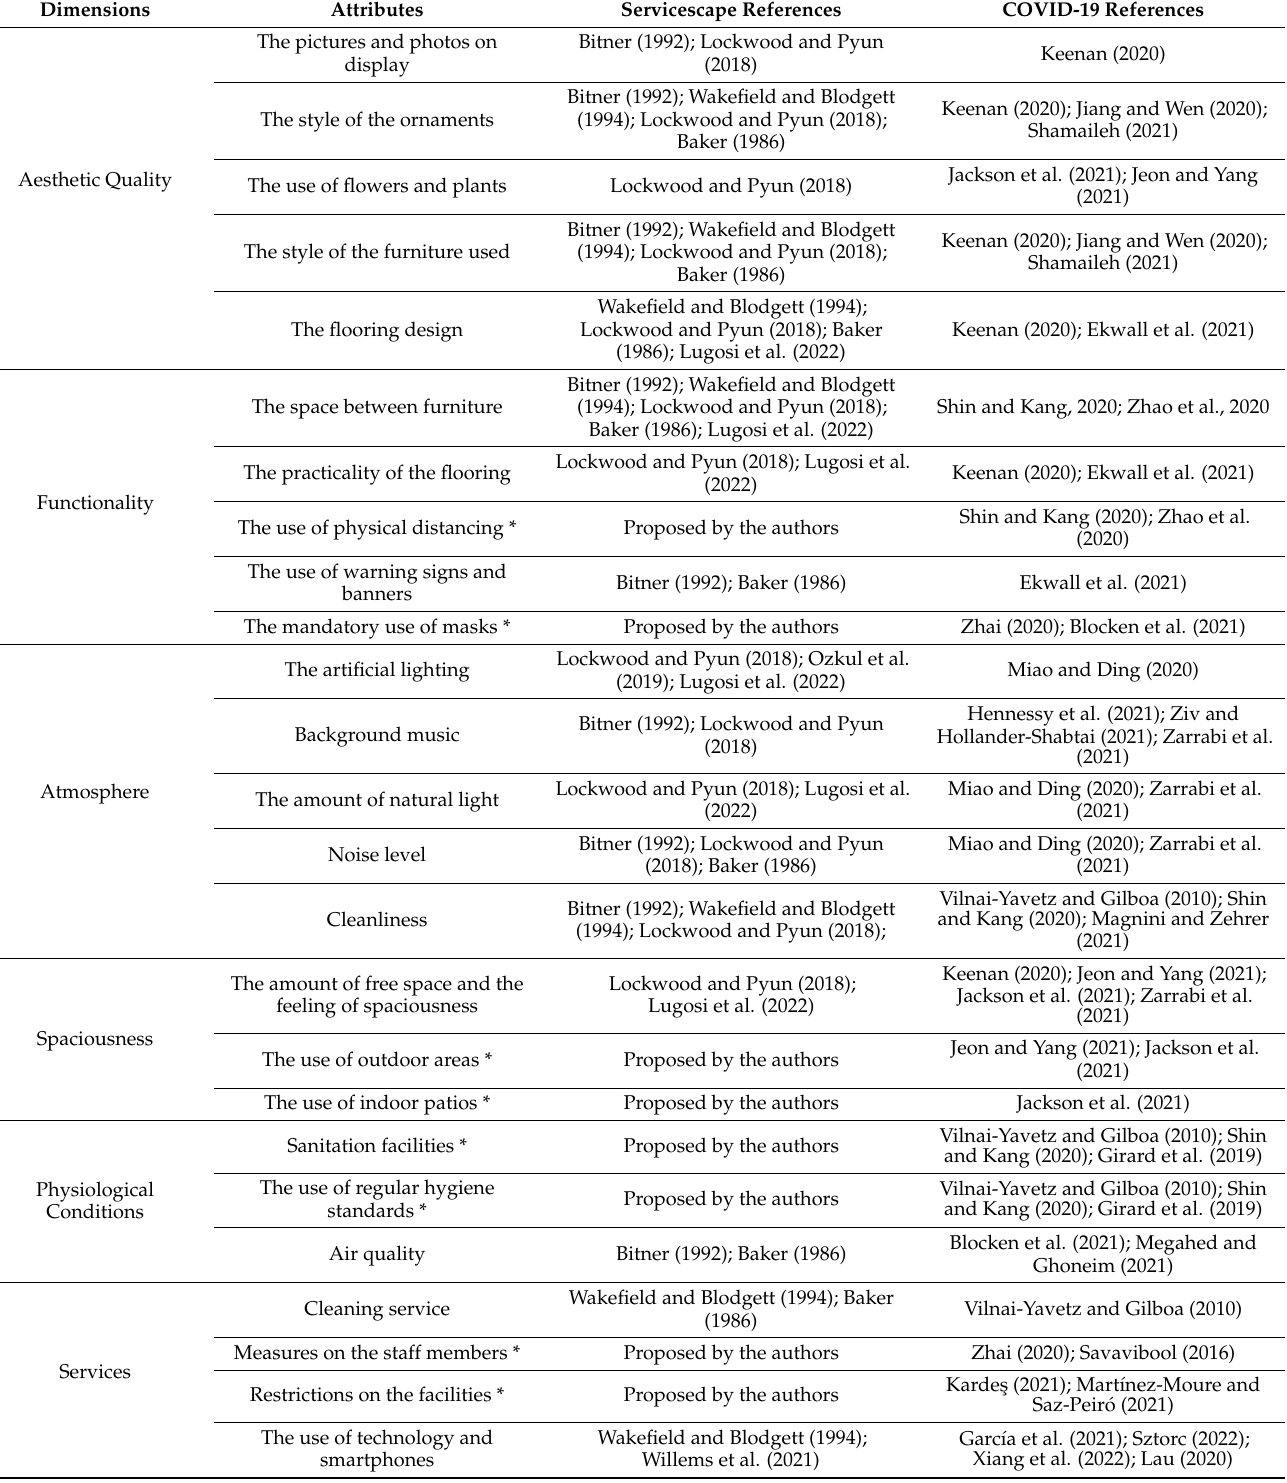
Table 1. The servicescape scale during an airborne health crisis developed by the